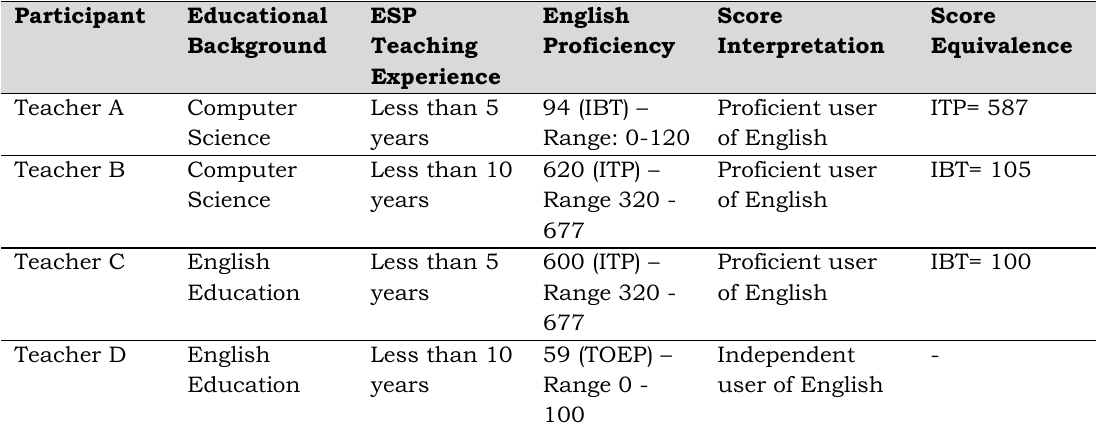
Table 1. Participants